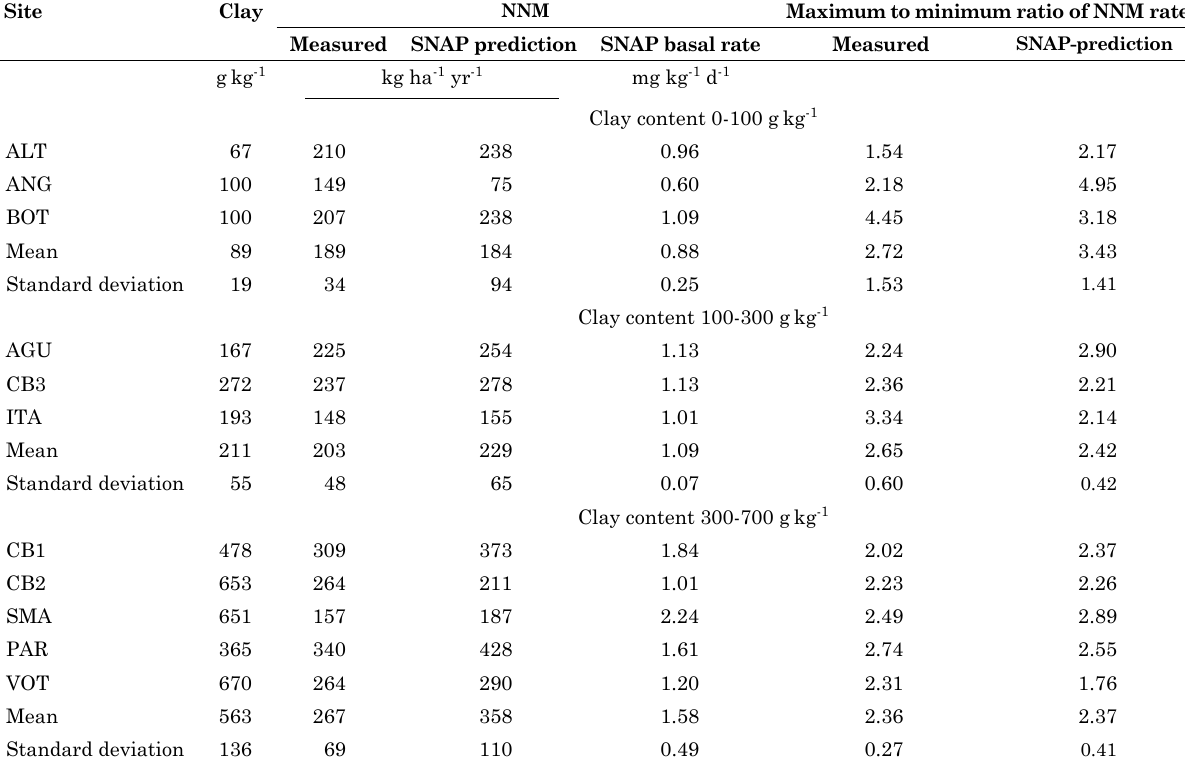
table 3. measured and sNAp-predicted rates and seasonality of net N mineralization (NNm) at individual sites grouped according to clay